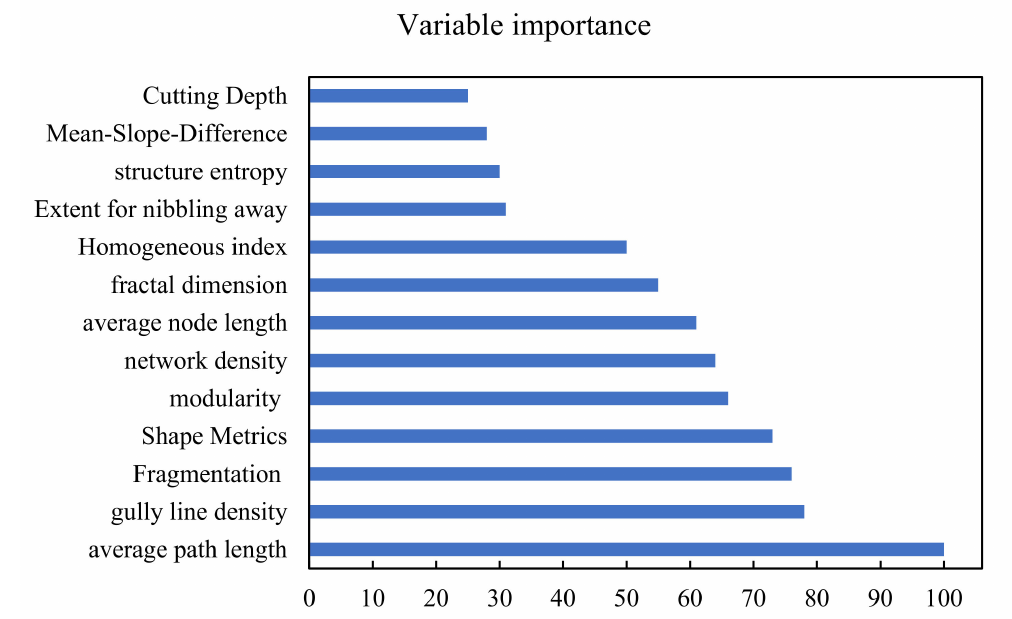
Figure 13. The variable importance for different quantitative indices based on the combination of watershed